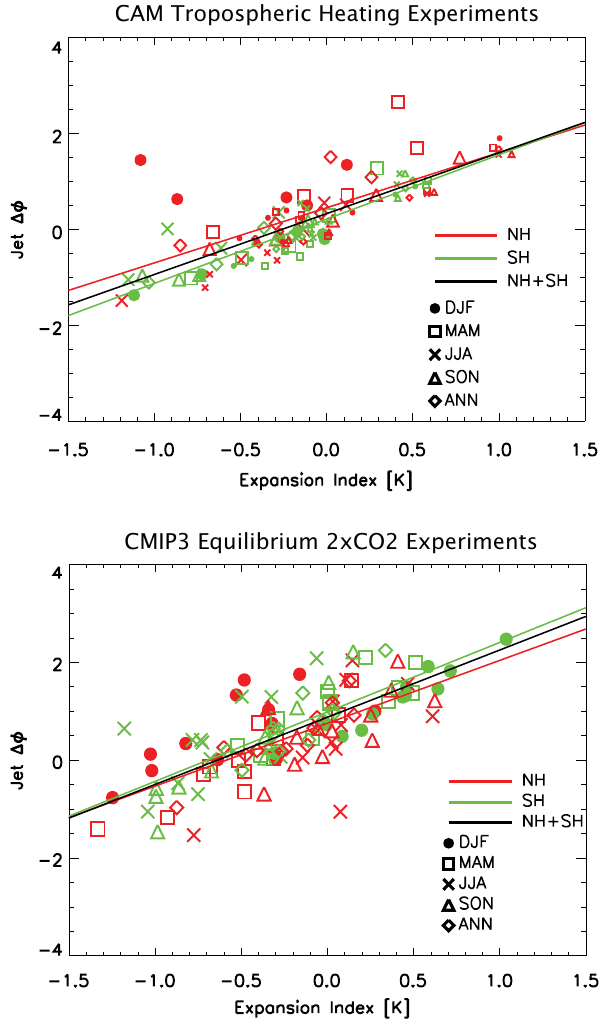
Fig. 10. Scatterplot of tropospheric poleward jet displacement ver- sus the expansion index for the (top panel) CAM tropospheric heating experiments and (bottom panel) 12 CMIP3 2 × CO2 equi- librium experiments. CAM tropospheric heating experiments in- clude the 5 global warming experiments (larger symbols; LTHT, LTHT2x, LTHT4x, 2 × CO2, 8 × CO2) and 6 latitude-restricted heat- ing experiments (smaller symbols; LTHT TR , LTHT ML , LTHT HL , LTHT2x TR , LTHT2x ML , LTHT2x HL ). Also included are the corre- sponding linear regression lines, all of which are significant at the 99% confidence